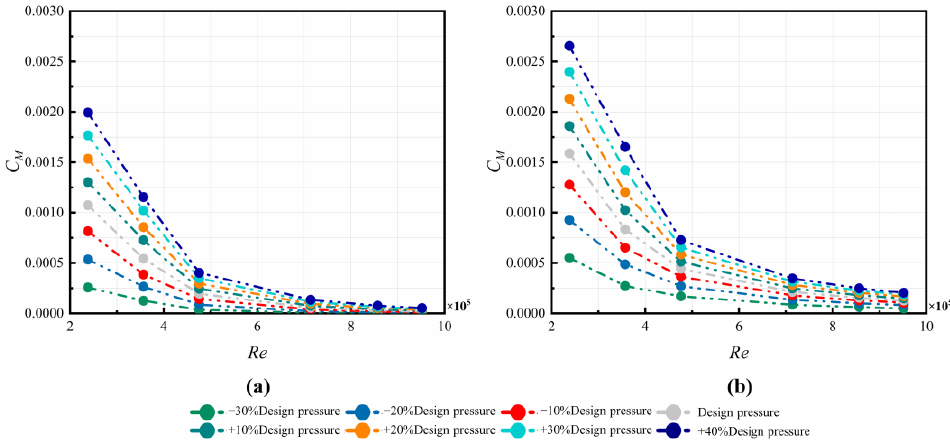
Figure 19. Variations of C M in C1 cavity at different 𝑝 𝑖𝑛,𝑡𝑜𝑡𝑎𝑙 and Re on: ( a ) rotor and ( b ) stator.